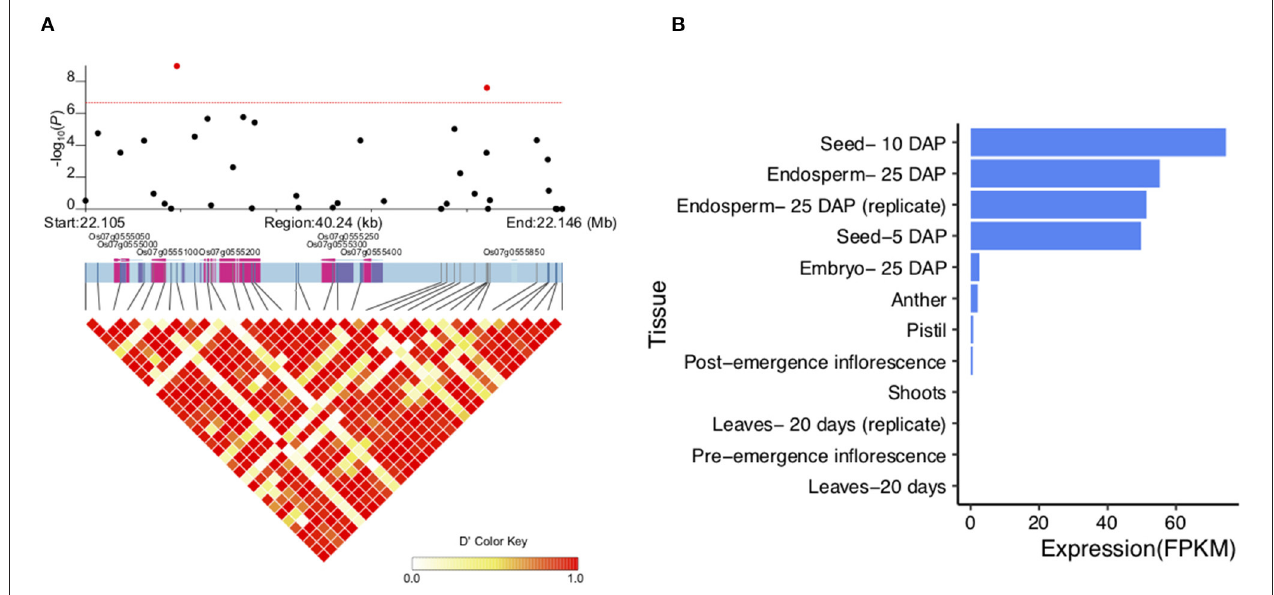
FIGURE 7 | Candidate genes in qLWR7-2 . (A) Local LD block of qLWR7-2 . Pink color represents the exons, and purple color represents untranslated region (UTR). (B) Expression levels of Os07g0555000 in 9 rice tissues.